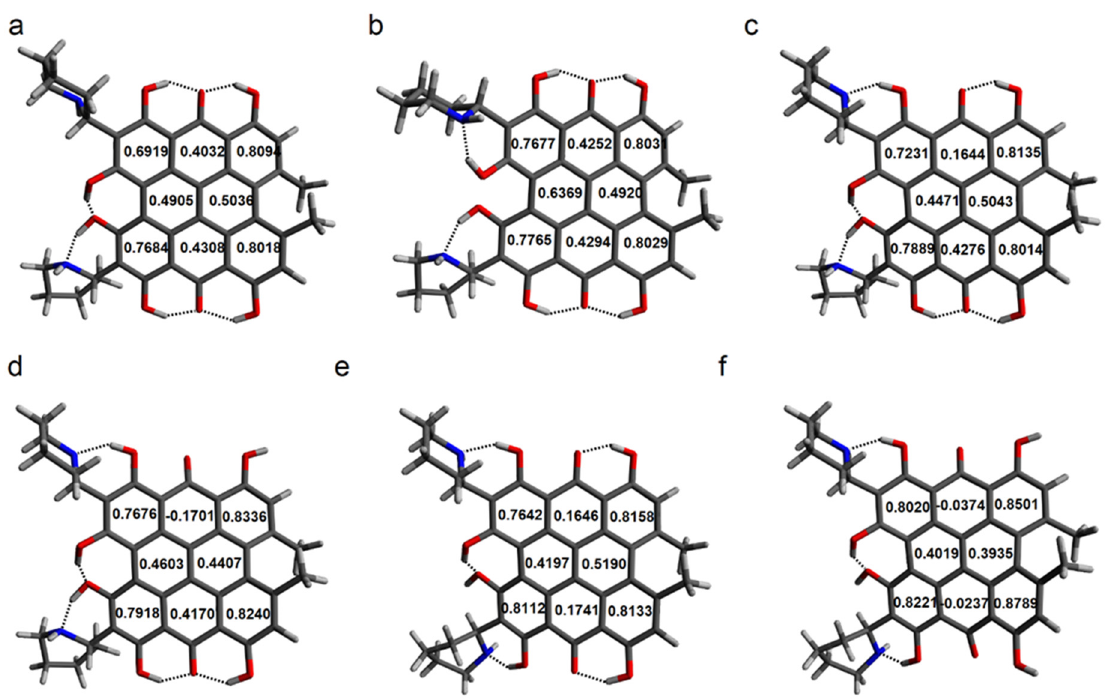
Figure 7. HOMA values calculated for ( a ) 31, ( b ) 32, ( c ) 33, ( d ) 34, ( e ) 35, and ( f ) 36 fagopyrin F conformers.